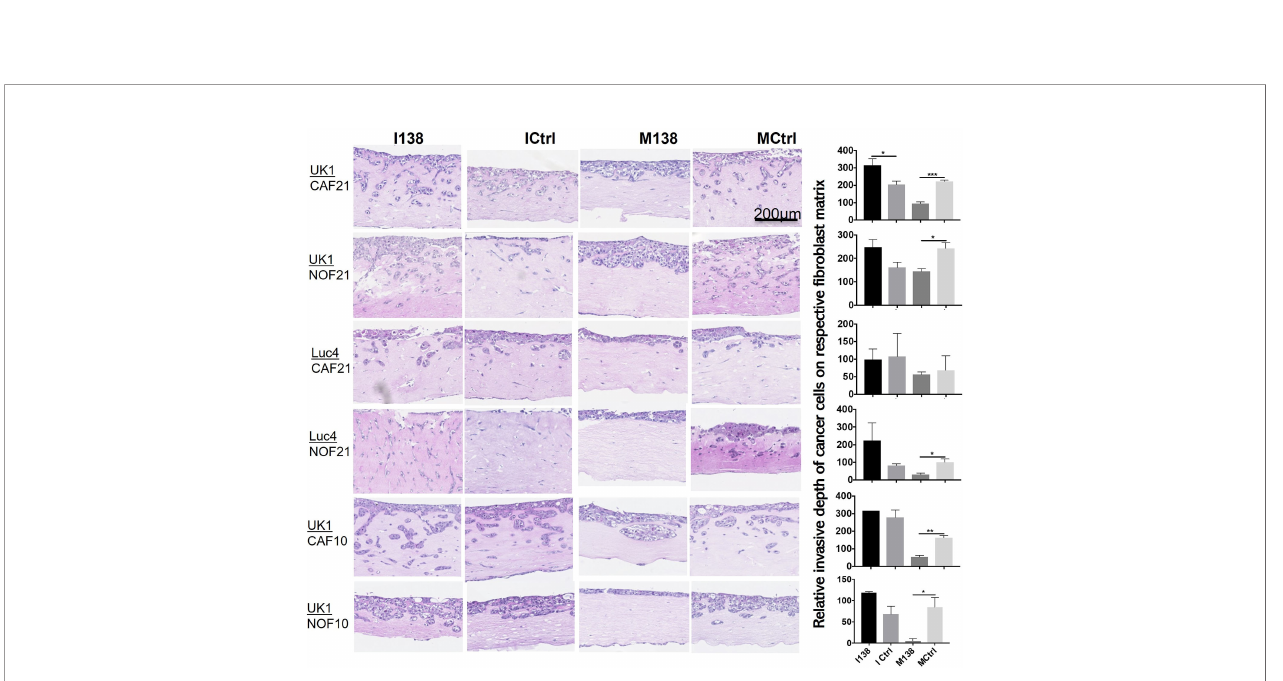
FIGURE 7 | Altered miR-138 expression in fi broblasts modulates invasion of adjacent OSCC cells. HE images of 3D organotypic co-culture depicting invasion of OSCC cells in fi broblast-collagen matrix. Measurement of corresponding invasion distance by OSCC cells on the right. * p < 0.05, ** p < 0.01, *** p < 0.001.